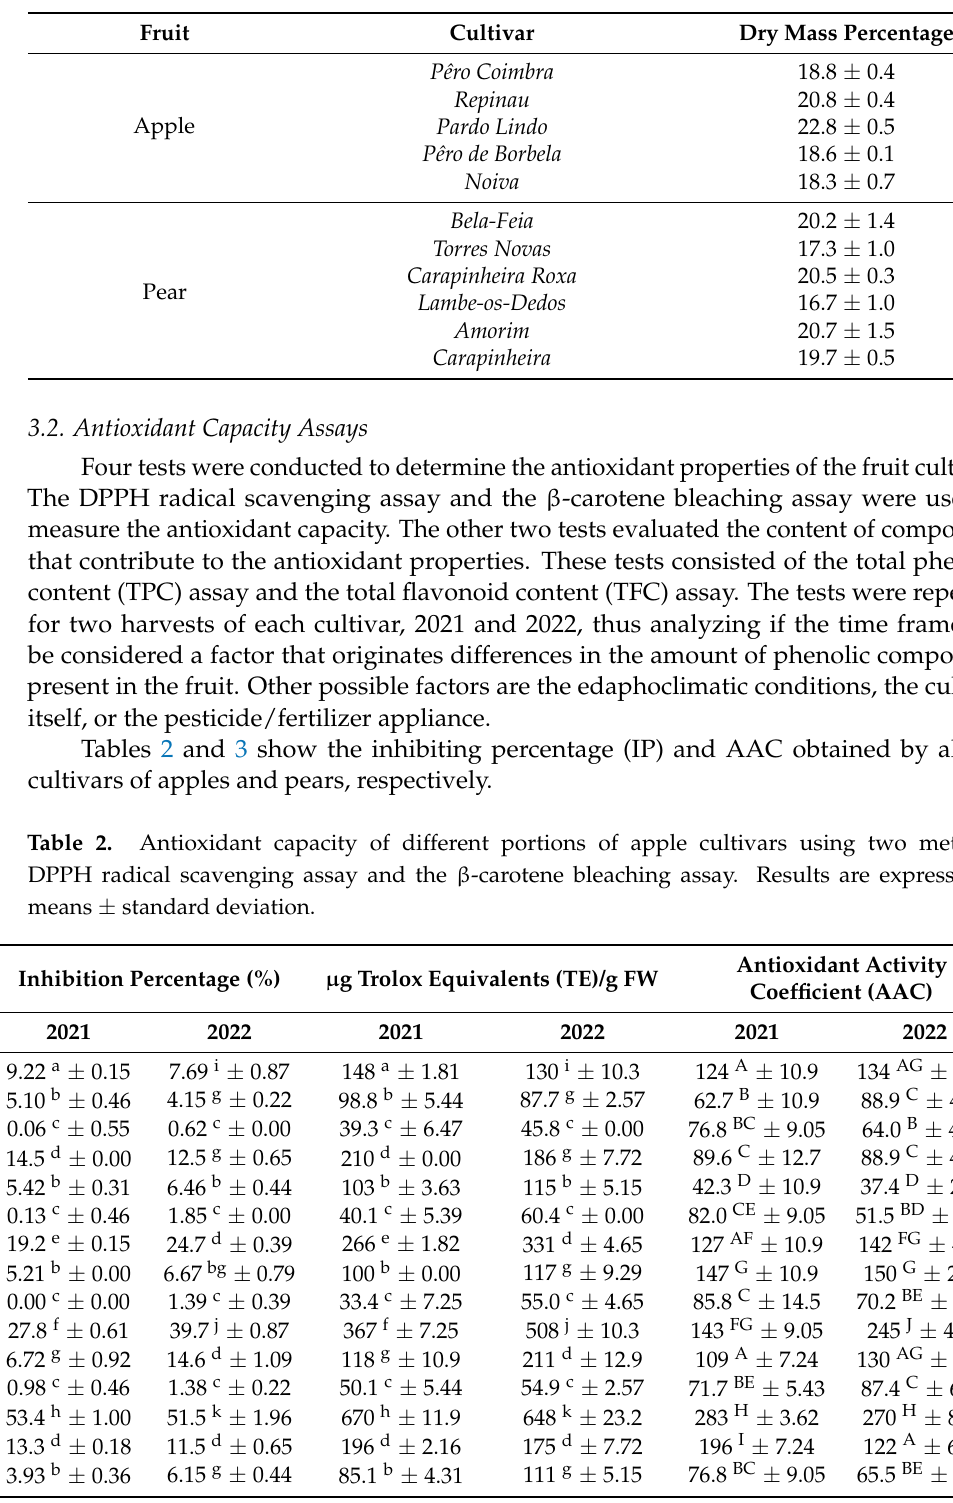
Dry mass percentage of apple and pear cultivars. Results are expressed in means ± standard deviation.